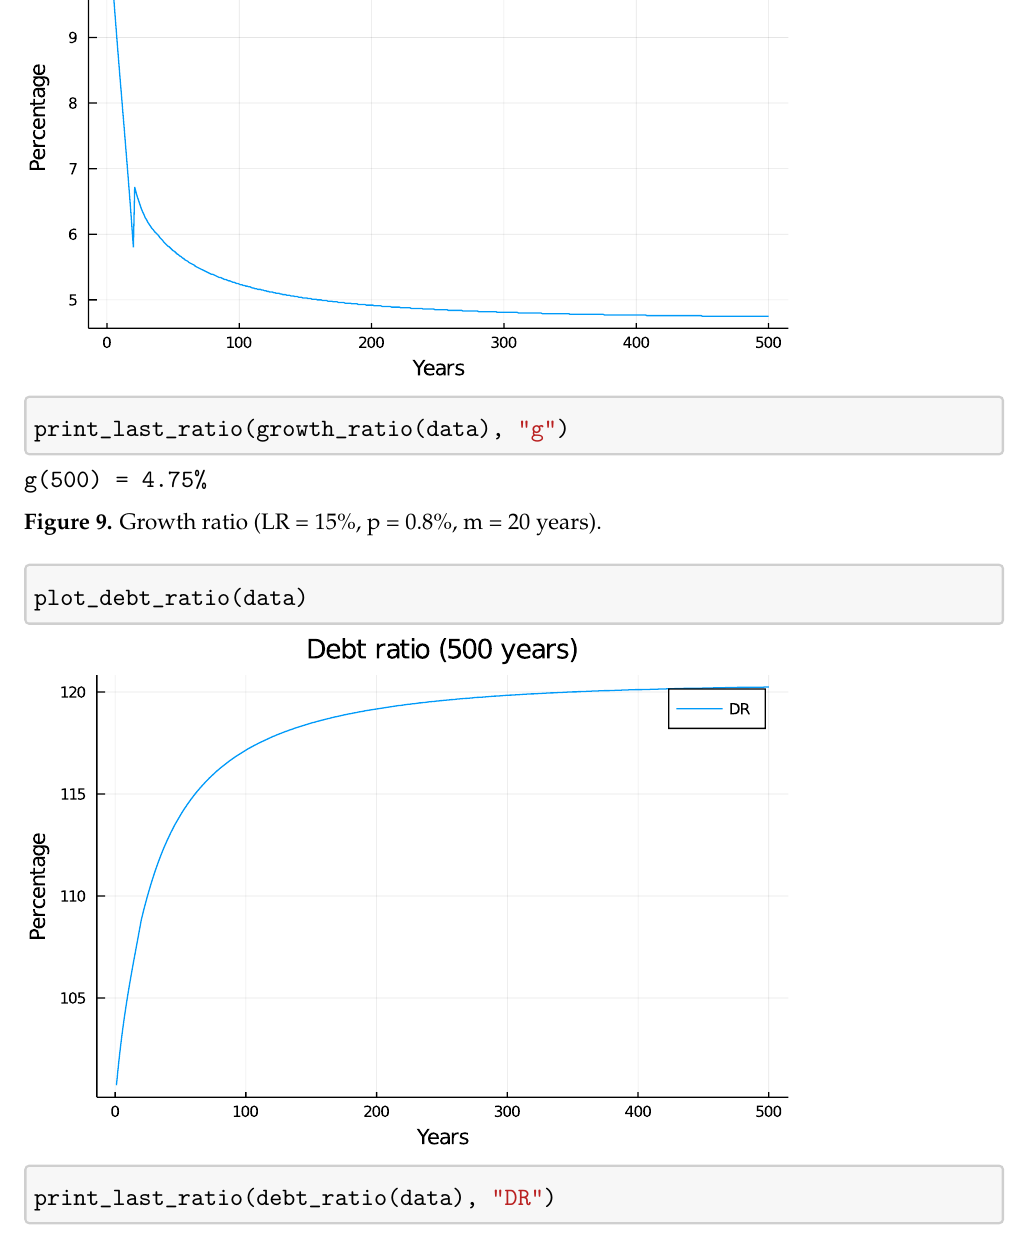
Figure 10. Debt ratio (LR = 15%, p = 0.8%, m = 20